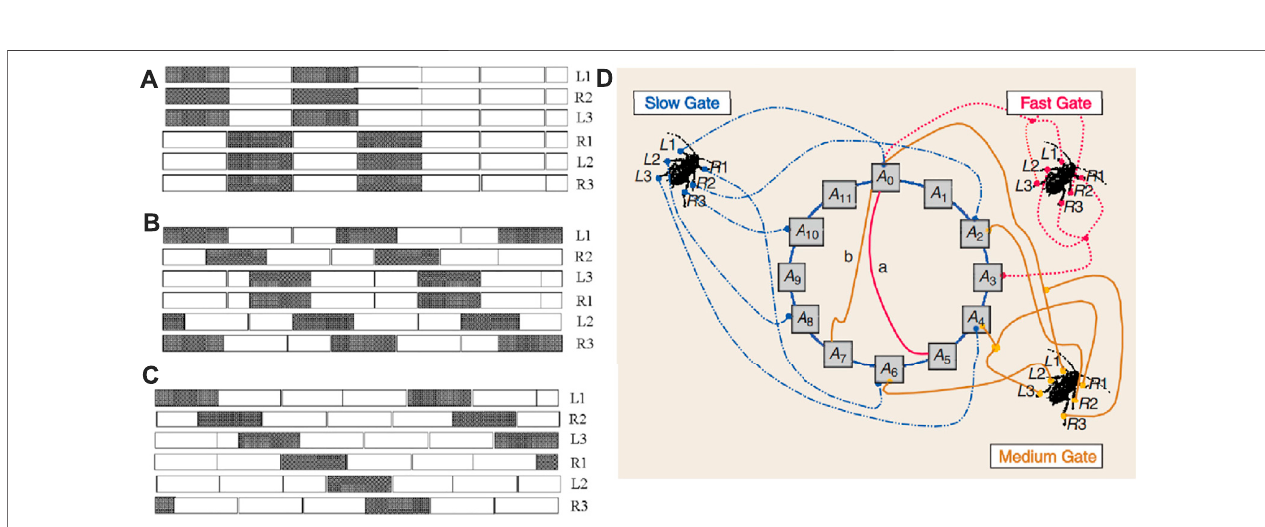
FIGURE 7 | The three gaits implemented in the hexapod robot: (A) fast, (B) medium, and (C) slow. (D) Scheme of the locomotion pattern generator network implementing the three gaits. Each gait is realized implementing rings of different sizes in the CNN structure, the smallest one associated to the fast gait, and the largest one associated to the slow